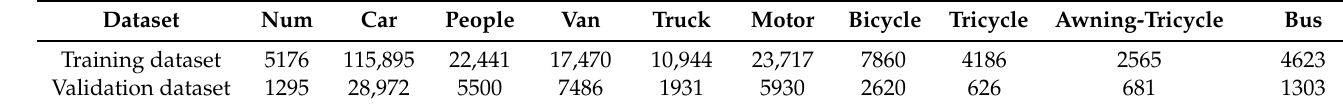
Table 1. Nums of different target in